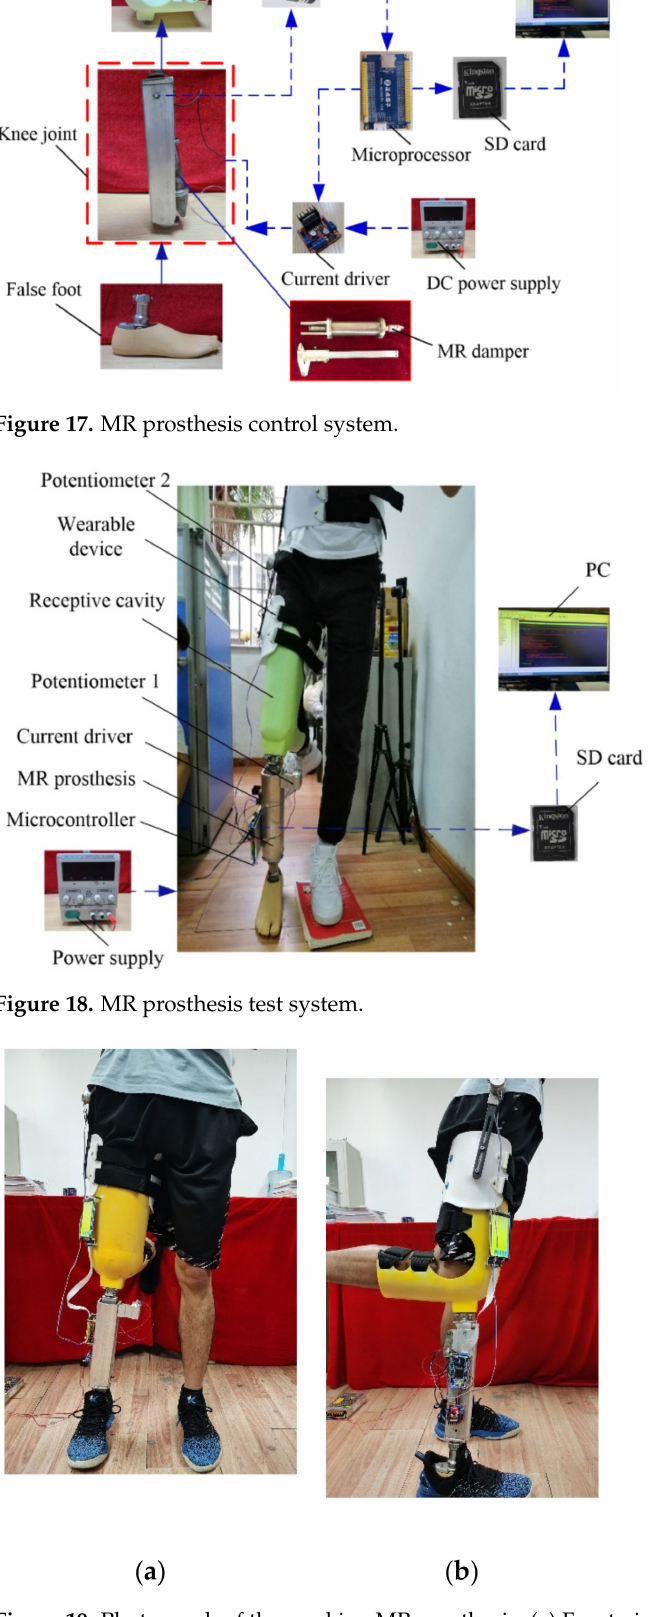
Figure 19. Photograph of the working MR prosthesis. ( a ) Front view and ( b ) side